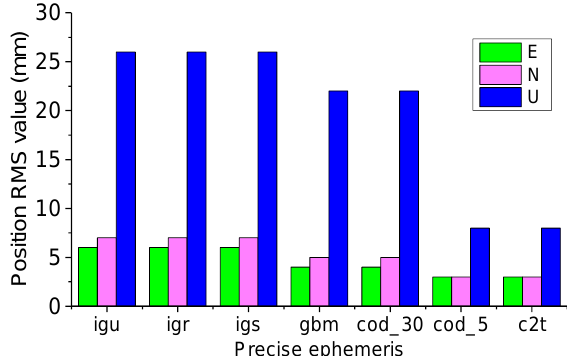
Figure 4. Position RMS value of GPS ARTK using different precise ephemeris for Bs.2.